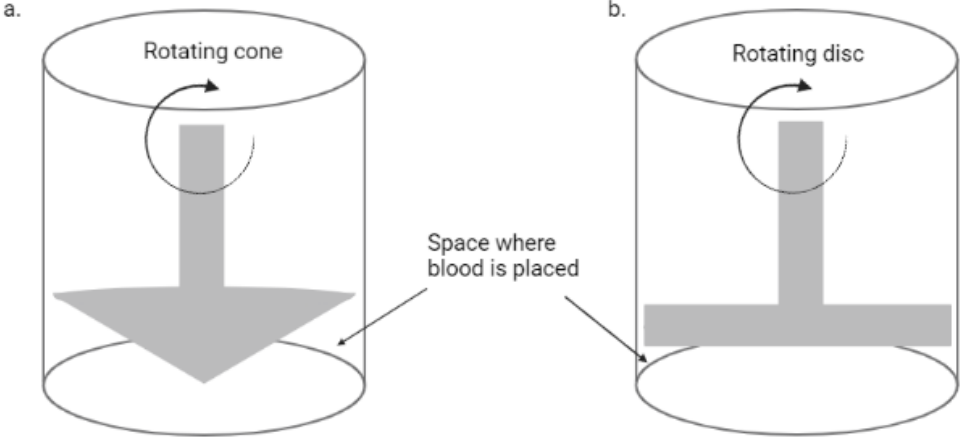
Figure 1. A simplified diagram of a rotational rheometer. ( a ) Cone and plate rheometer; ( b ) two-disc rheometer (Created with BioRender.com).